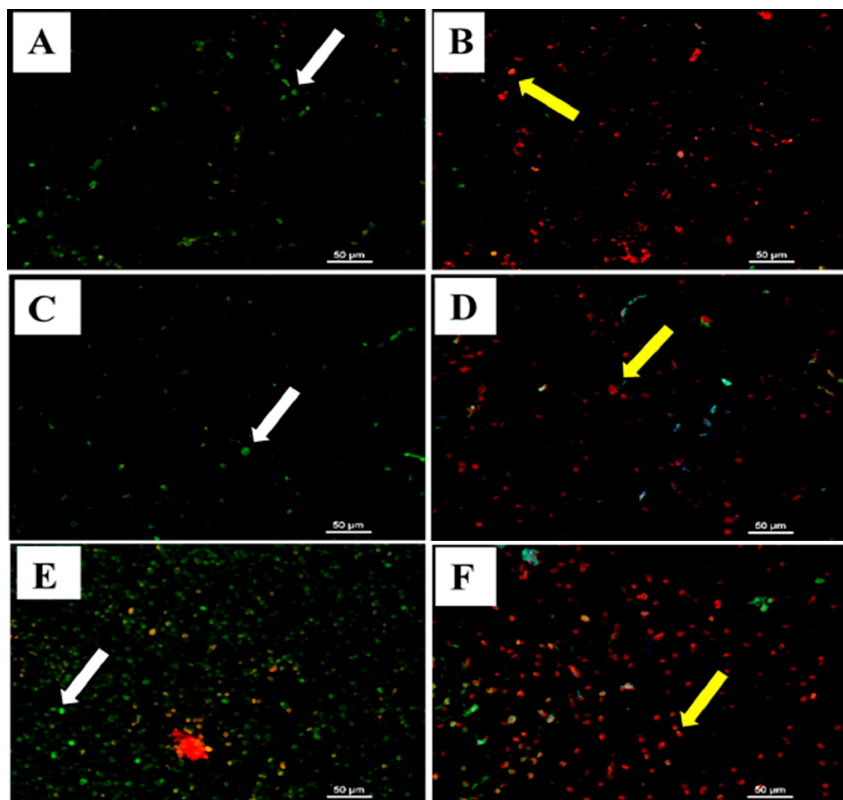
Figure 6. Detection of apoptosis using Terminal deoxynucleotidyl transferase dUTP nick end labelling (TUNEL) assay in the spleen, lymph nodes and liver tissues of male ICR-mice treated with 80 mg/kg n -ethyl- n -nitrosourea (ENU) twice at one-week interval. Key: ( A ) Photomicrograph of section of spleen from a mouse in group A showing few apoptotic cells (white arrow) in the spleen, characterised by green fluorescence (×400). ( B ) Photomicrograph of section of spleen from a mouse in group B showing numerous leukaemic cells (yellow arrow) in the spleens of ENU injected mice 12 weeks post injection; the leukaemic cells were characterised by red fluorescence (yellows arrow) when viewed under fluorescence microscope (×400). ( C ) Photomicrograph of section of lymph node from a mouse in group A showing few apoptotic cells (white arrow) in the lymph node, characterised by green fluorescence (×400). ( D ) Photomicrograph of section of lymph node from a mouse in group B showing numerous lymphoma cells (yellow arrow) in the lymph node of an ENU-injected mouse 12 weeks post injection; the lymphoma cells were characterised by red fluorescence (yellow arrow) when viewed under fluorescence microscope (×400). ( E ) Photomicrograph of section of liver from a mouse in group A showing few apoptotic cells (white arrow) in the liver of the mouse, characterised by green fluorescence (×400). ( F ) Photomicrograph of section of liver from a mouse in group B showing numerous leukaemic cells (yellow arrow) metastasised to the liver of ENU treated mice 12 weeks post injection; the metastasised leukaemic cells were characterised by red fluorescence (yellow arrows) when viewed under fluorescence microscope (×400). Scale bars are indicated at the respective images. 2.7. Western Blot for the Expression of VEGF, BCL2 and BAX Proteins in the Spleen and Lymph Nodes The results of the Western blot analyses for the expression of VEGF, BCL2 and BAX in the spleens of male ICR-mice treated with 80 mg/kg doses of ENU are presented on Figure 7 and Table 5. The proteins beta actin, VEGF, BCL2 and BAX were all detected in both the control and the ENU treated groups (Figure 7). The results of the quantification of each of the protein bands revealed